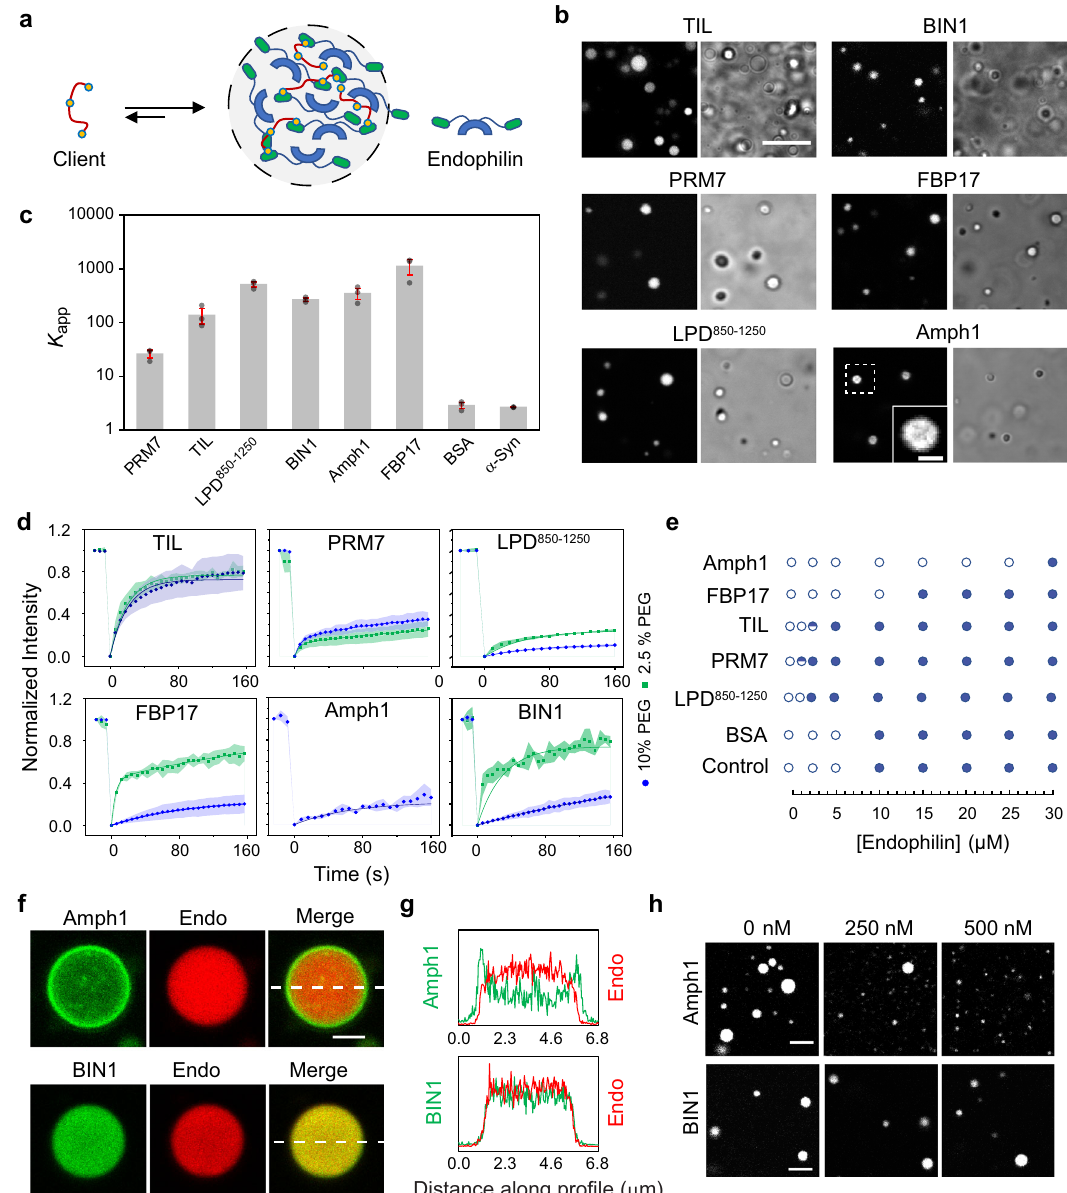
Fig. 2 | Endophilin binding partners partition into LLPS droplets and exhibit regulatorybehavior.a GraphicalillustrationofendophilindropletformedbyLLPS allowing partitioning of endophilin binding proteins as clients into the condensed phase. b Confocal images showing partitioning of fl uorescently labeled TIL (Alexa 488)of β 1-adrenergicreceptor,PRM7(Alexa633)oflamellipodin,LPD 850 – 1250 (Alexa 647), BIN1 isoform 9 (Alexa 488), FBP17 (Alexa 488) and amphiphysin (Amph1) (Alexa488)intodropletsformedbyendophilin(25 µ M)inthepresenceof10%PEG. The corresponding transmission images show the endophilin droplets. Scale bar 10 µ m.InthecaseofAmph1,anenlargedimageisshownintheinset(scalebar2 µ m) for the droplet surrounded by dotted lines to illustrate the peripheral distribution of the protein. c Apparent partition coef fi cients ( K app ) for the clients within endo- philin droplets as determined from fl uorescence intensities inside and outside the droplets. Bar plot represents mean±s.e.m. from three independent experiments (gray circles) where 10 – 20 droplets were considered per experiment. d FRAP pro fi les of the client proteins partitionedwithin endophilin droplets formed in the